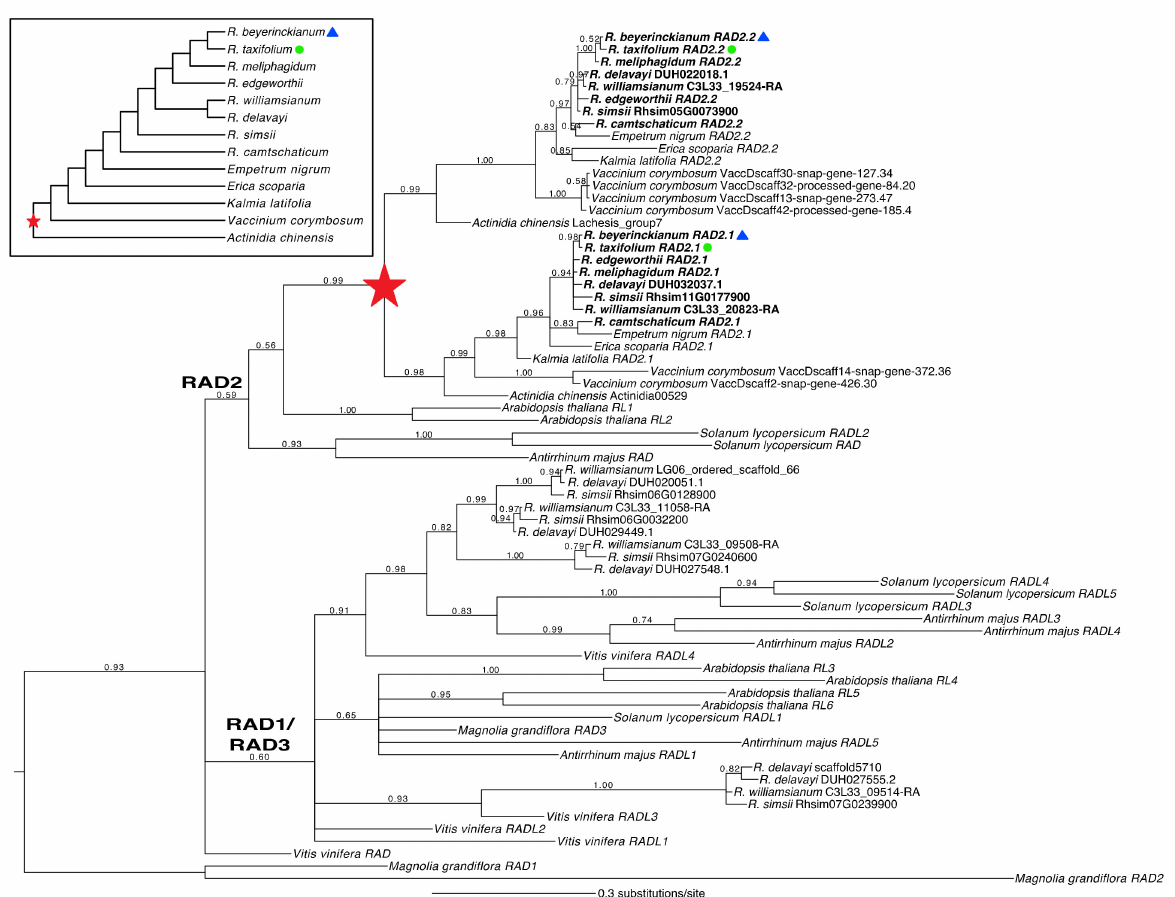
Figure 3. Evolution of RADIALIS ( RAD ) homologs in Rhododendron (Ericaceae) and outgroups. Reconstructed Bayesian RAD phylogeny with posterior probabilities at all nodes. One gene duplication in the RAD2 lineage, indicated by a filled red star, occurred in an ancestor of the Ericales. Experimental species are highlighted with a blue triangle (bilateral symmetry) and a green circle (radial symmetry). Inset shows sampled taxa in phylogenetic context, based on prior studies